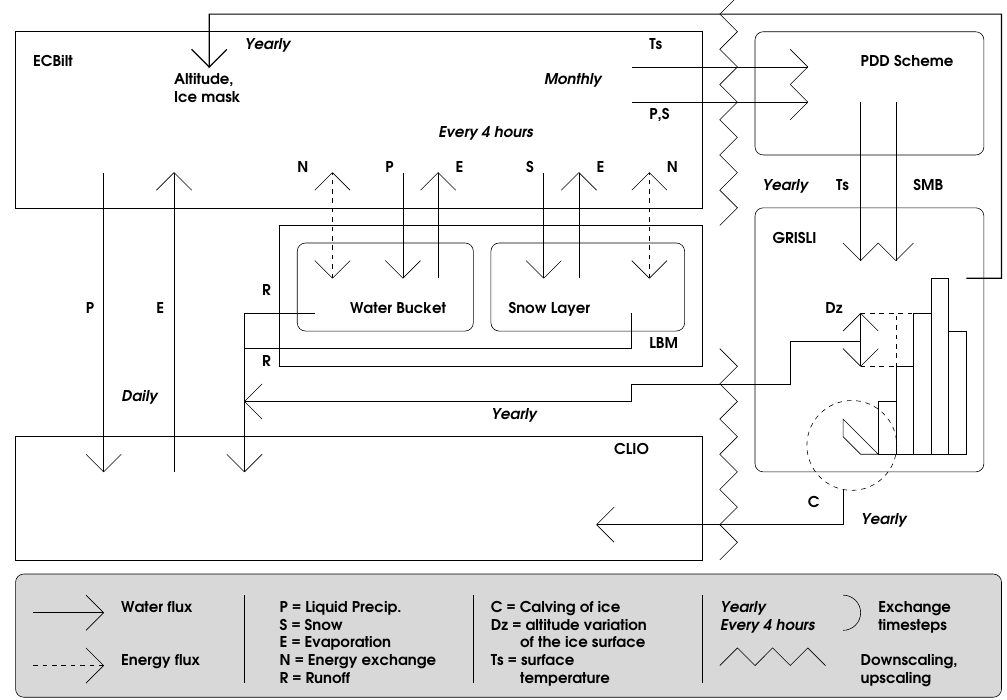
Figure 4. Scheme presenting the method used for coupling the ECBilt, CLIO and GRISLI models, including water exchange fluxes, energy fluxes and timesteps.